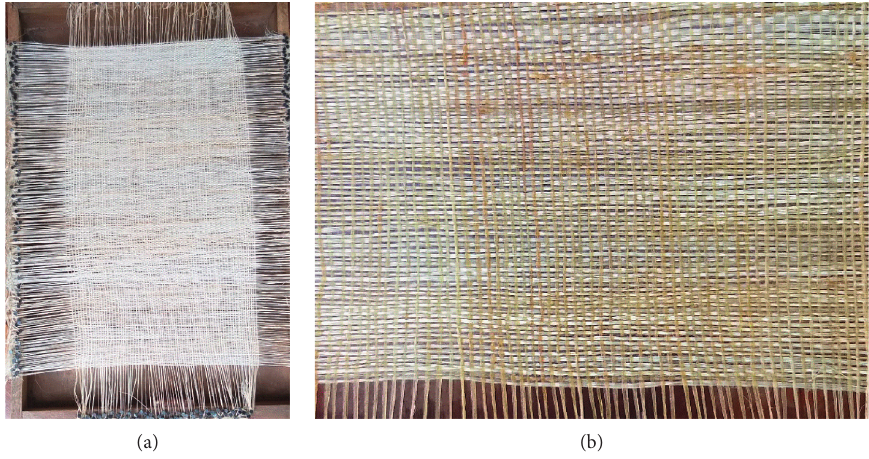
Figure 3: (a) Wooden frame and interlacing of threads (0 ° /90 ° ); (b) prepared woven sisal